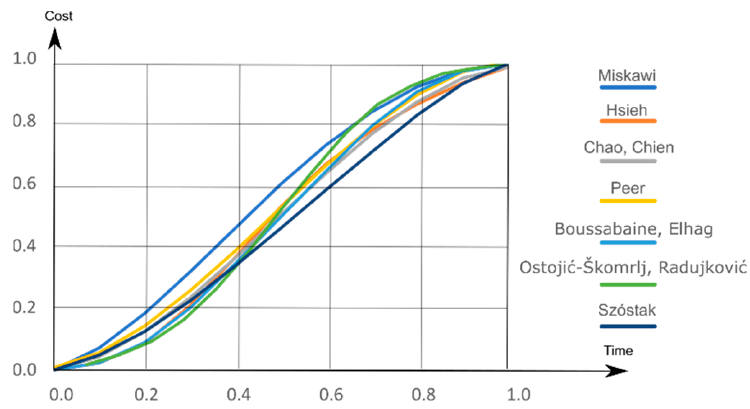
Figure 2. Cost curve graphs proposed by individual researchers.